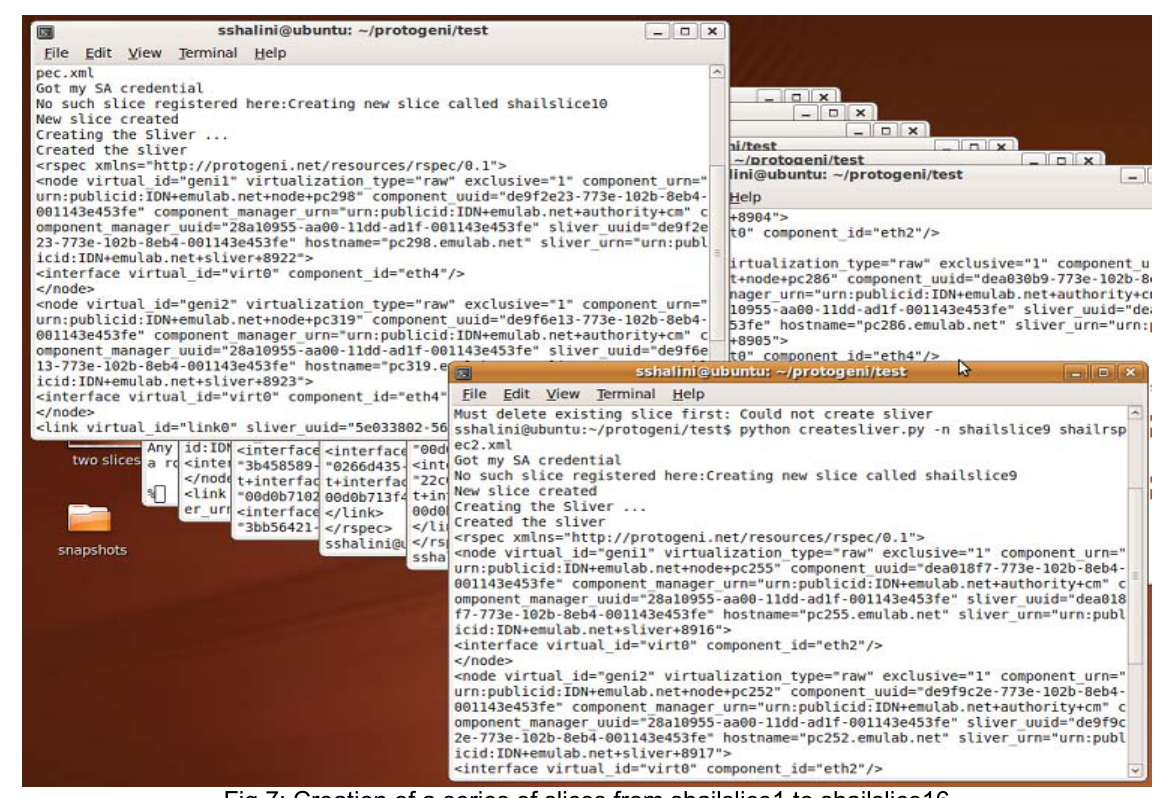
Fig.7: Creation of a series of slices from shailslice1 to